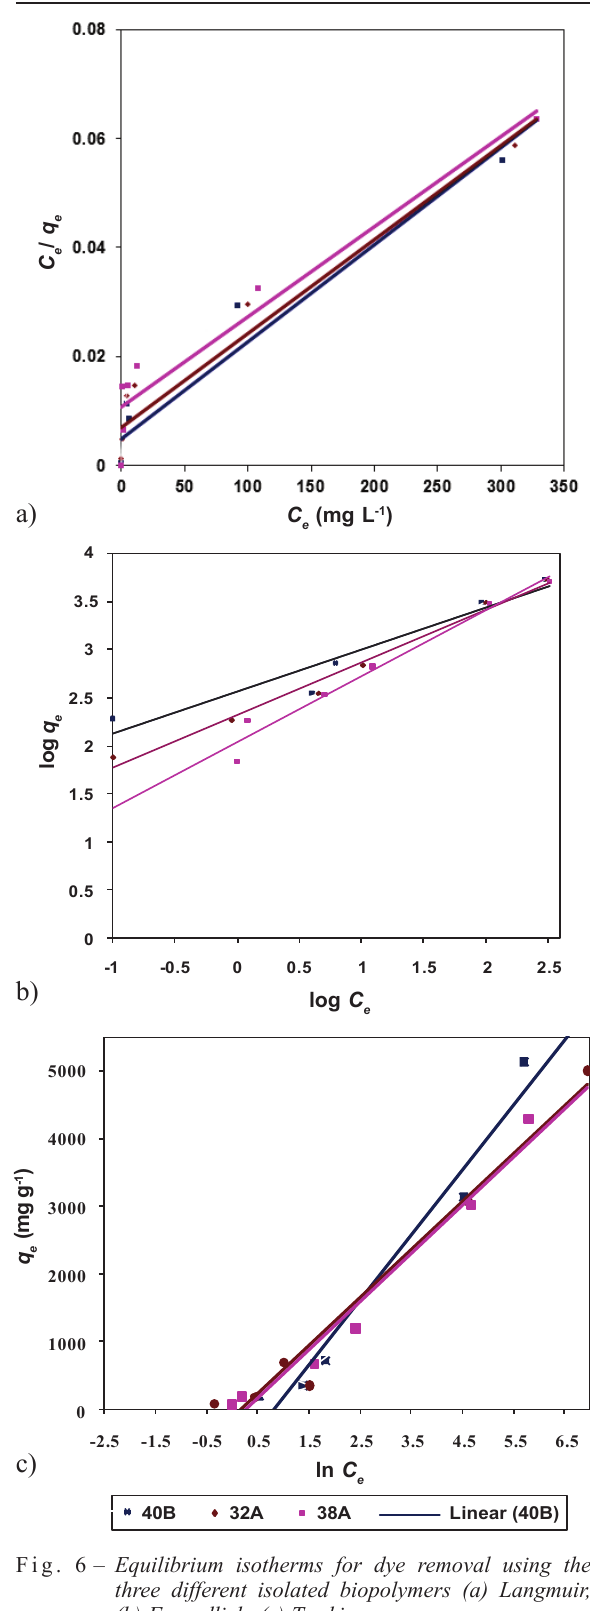
Fig. 6 – Equilibrium isotherms for dye removal using the three different isolated biopolymers (a) Langmuir, (b) Freundlich, (c)